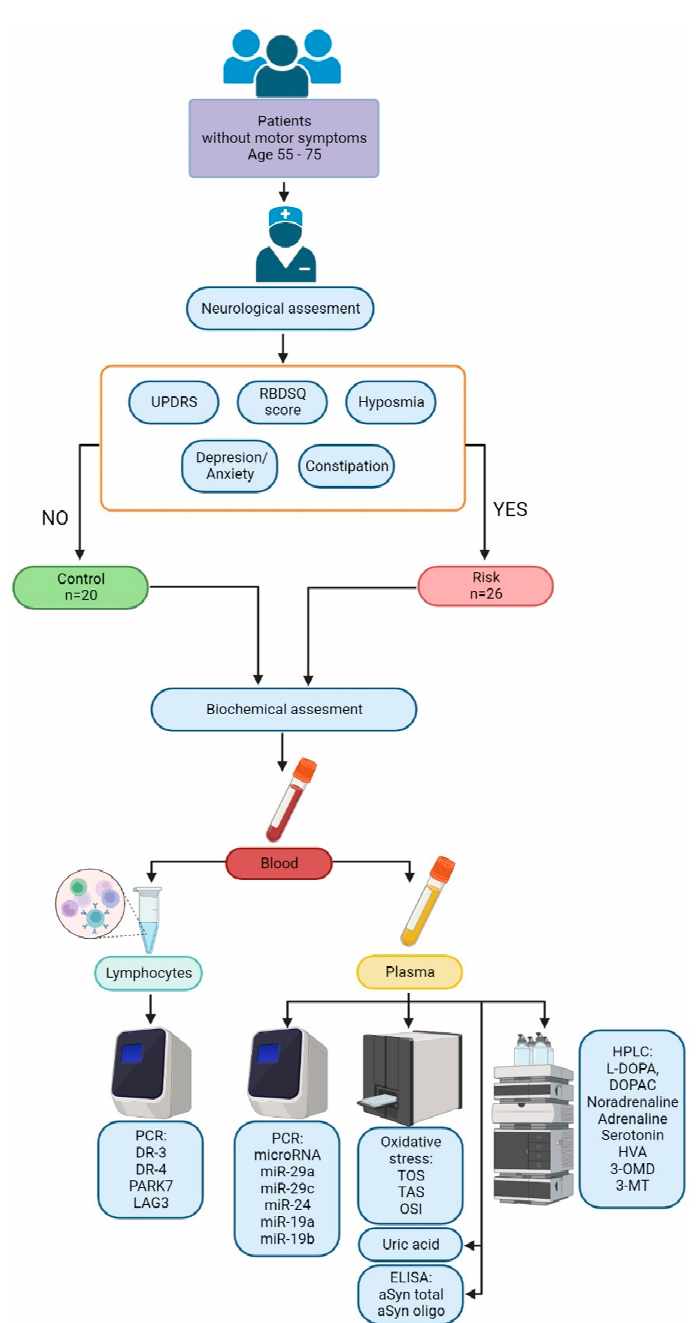
Figure 13. Study design to include patients in the risk group for developing Parkinson’s disease at the prodromal stage and in the control group, as well as to search for changes in the blood considered potential biomarkers of the preclinical stage. RBDSQ—the REM Sleep Behavior Disorder Screening Questionnaire; UPDRS—Unified Parkinson’s Disease Rating Scale, TOS—total oxidant